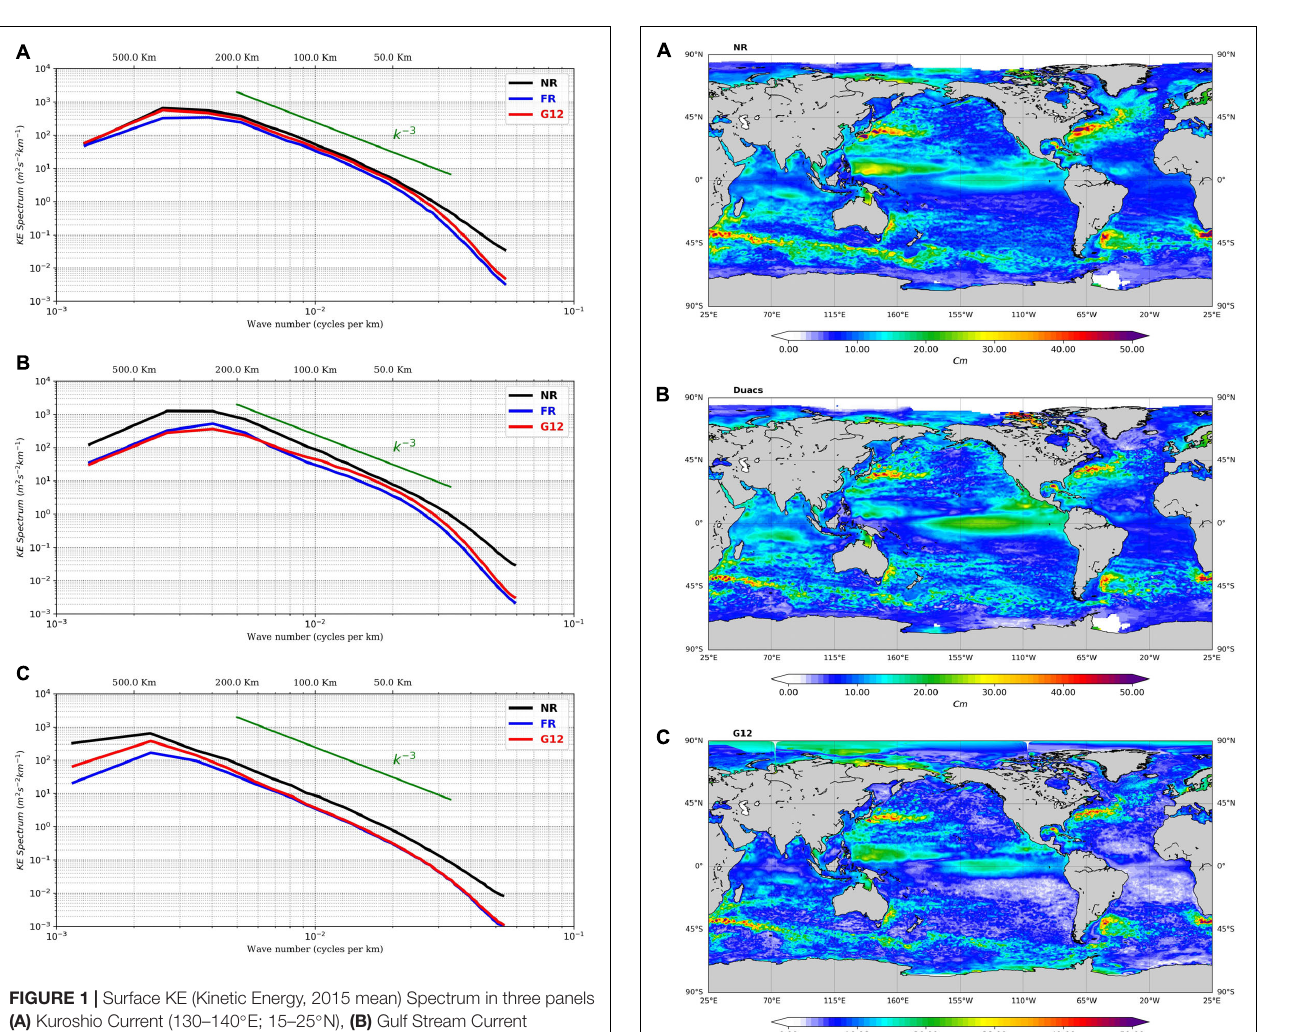
same observation error as the one used in the G12 system (see Lellouche et al., 2013; Lellouche et al.,